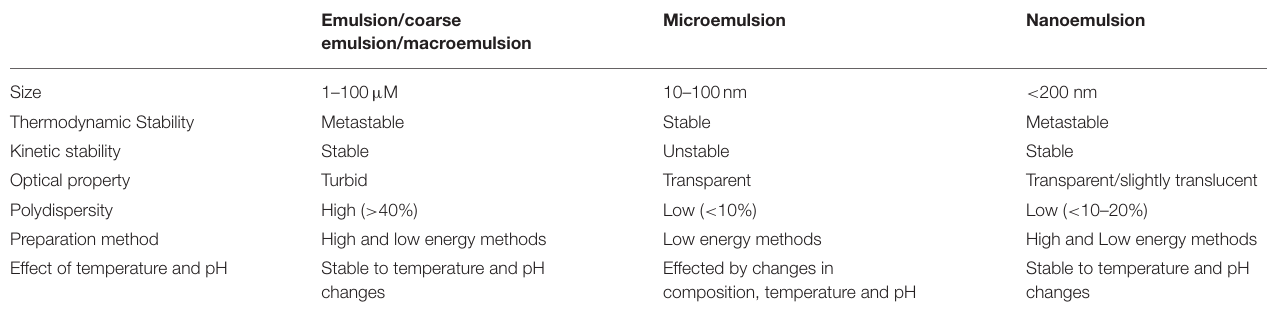
TABLE 1 | Emulsion types: physicochemical properties, stability, and preparation